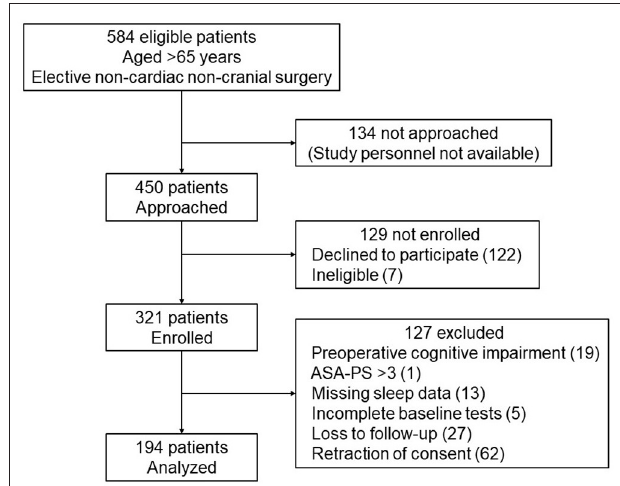
FIGURE 1 | STROBE flow diagram for the included patients. Four hundred and fifty patients were approached for study participation, and 321 were enrolled after providing written informed consent. Subsequently, 127 patients were excluded, leaving 194 patients for the final analysis. ASA-PS, American Society of Anesthesiologists Physical